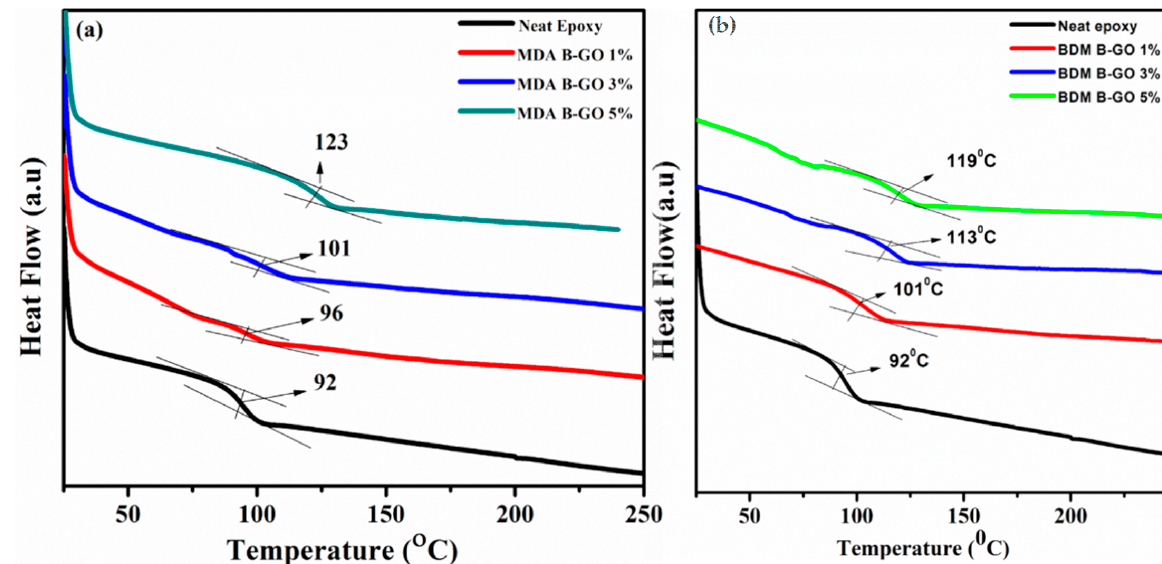
Figure 9. DSC thermograms of ( a ) Neat epoxy and MDA-B-GO-epoxy nanocomposites. ( b ) Neat epoxy and BDM-B-GO-epoxy nanocomposites.